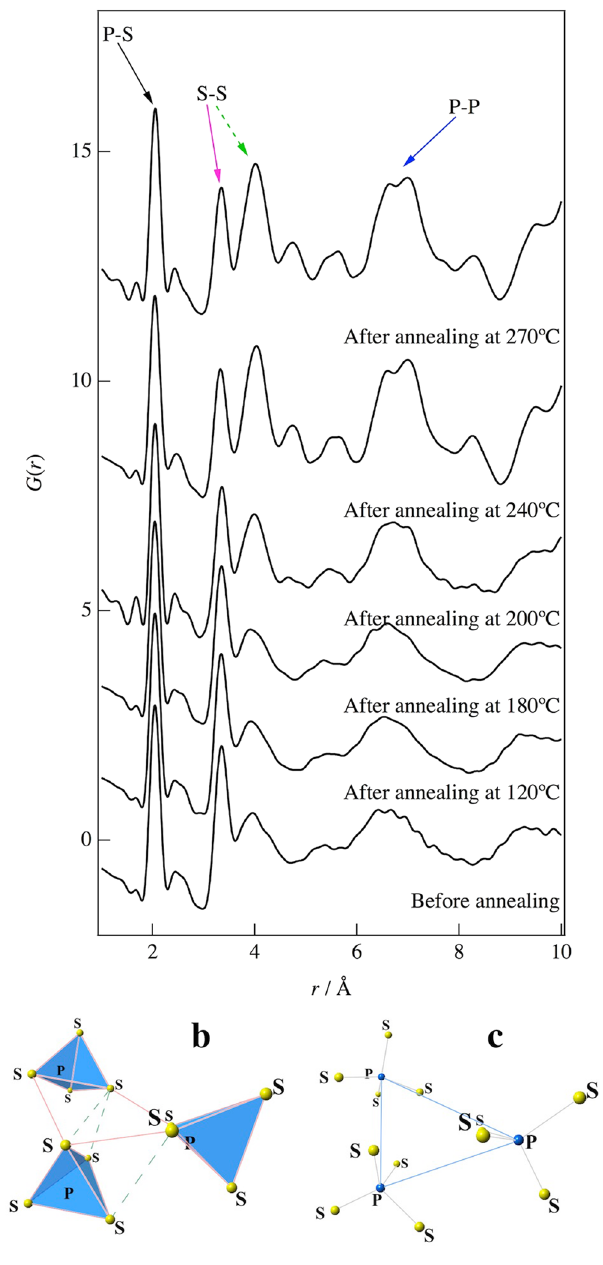
Figure 3. Reduced pair distribution functions, G ( r ), obtained from a Fourier transformation of S ( Q ) and Atomic configurations for the 75Li 2 S-25P 2 S 5 glasses: ( a ) G ( r ) before annealing and after annealing at 120 °C, 180 °C, 200 °C, 240 °C, and 270 °C. ( b ) Typical atomic configuration of S-S correlations. The correlations at around 3.3 Å and 4.1 Å are connected by pink and green lines, respectively. The PS 4 tetrahedral anions are highlighted by blue. ( c ) Typical atomic configuration of P-P correlations. The correlations at around 7.0 Å are connected by blue